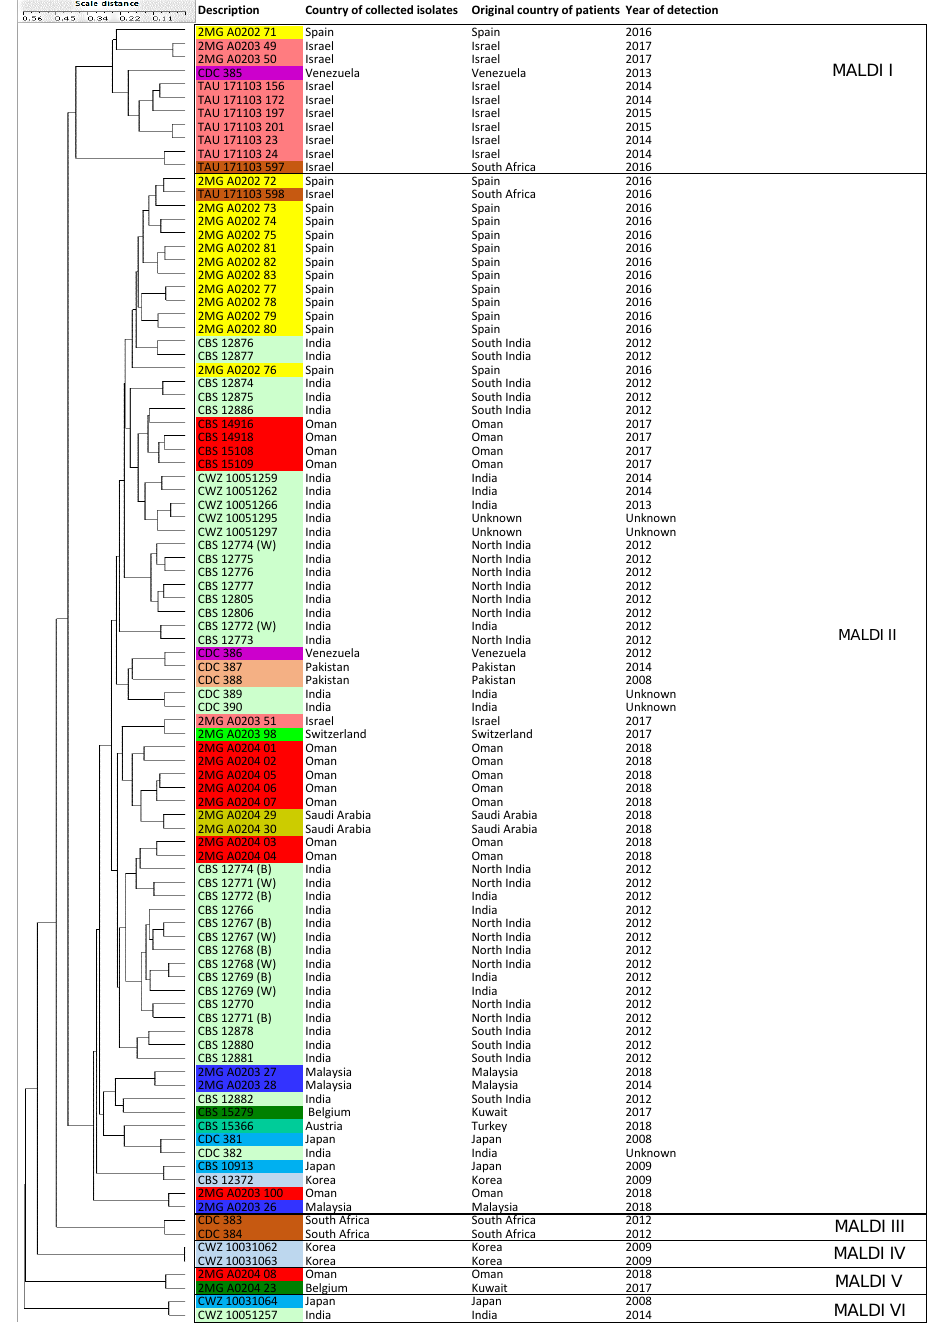
Figure 4. A UPGMA dendrogram was generated with BioloMICS v12 for 96 C. auris isolates by MALDI-TOF MS. Two main clusters were made, namely, MALDI I and MALDI II, with eight isolates forming basal lineages without assignment to a cluster. The color coding used for this dendrogram was the same as Figure